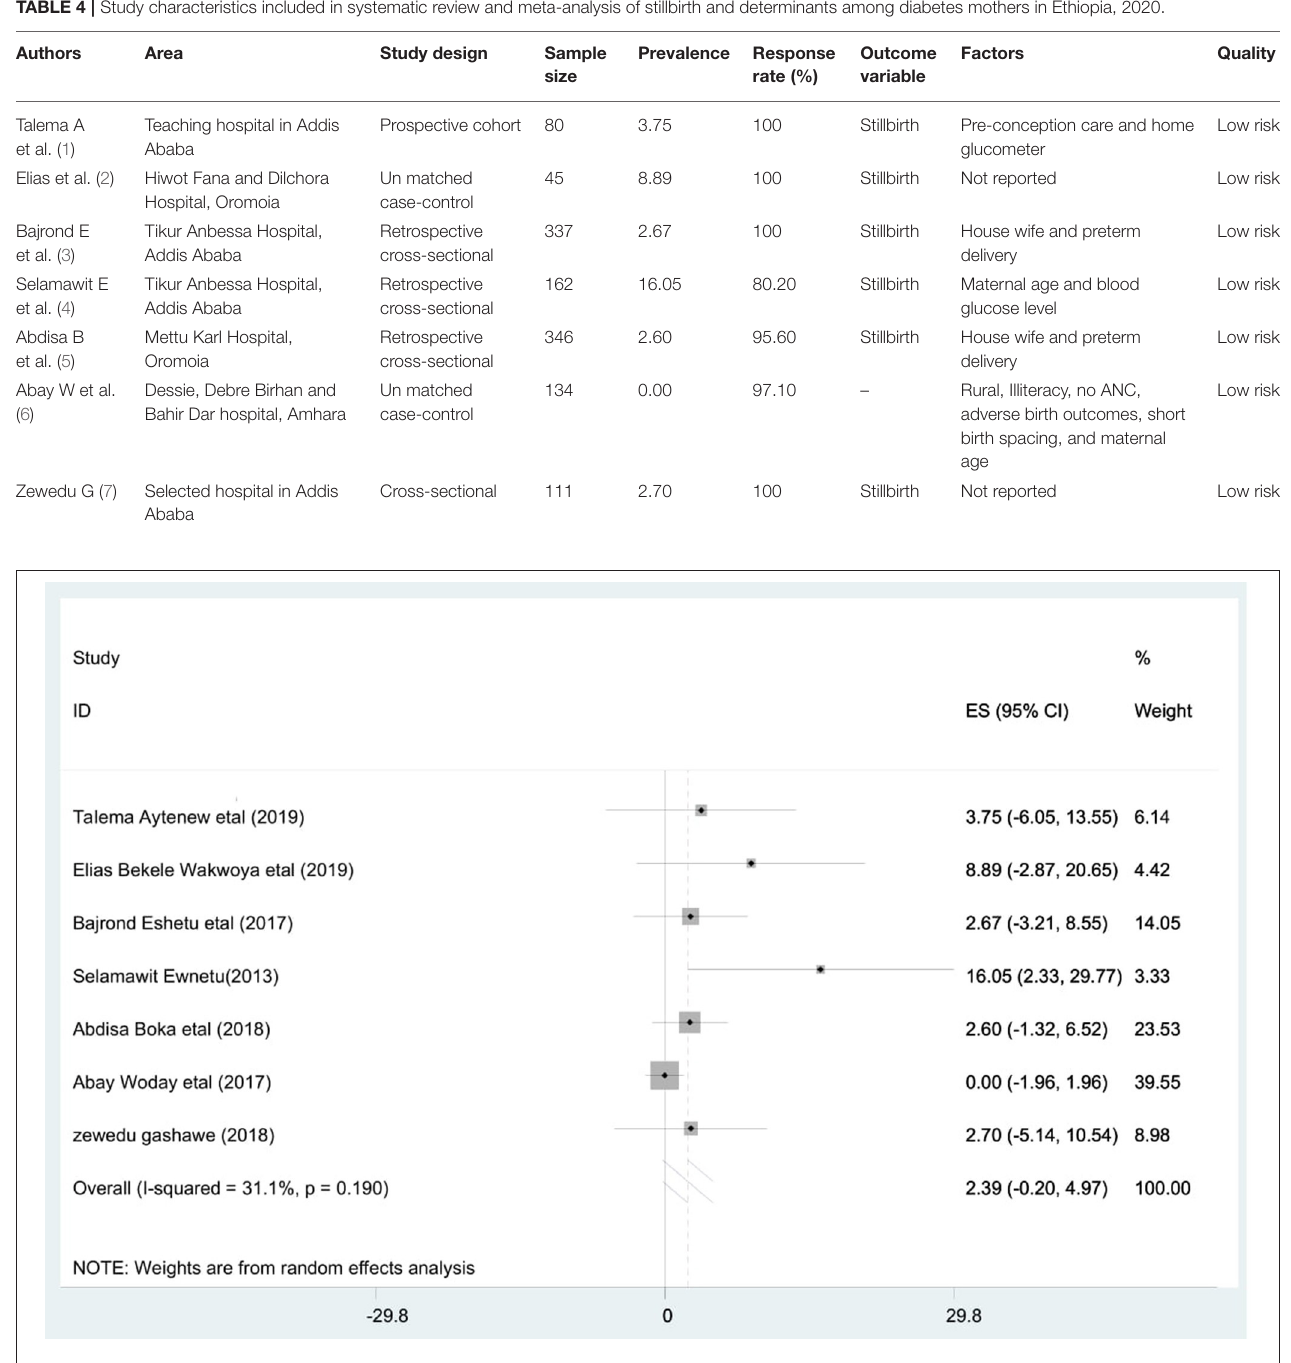
FIGURE 2 | Forest plot of pooled prevalence of stillbirths among diabetic mothers in Ethiopia, 2020.